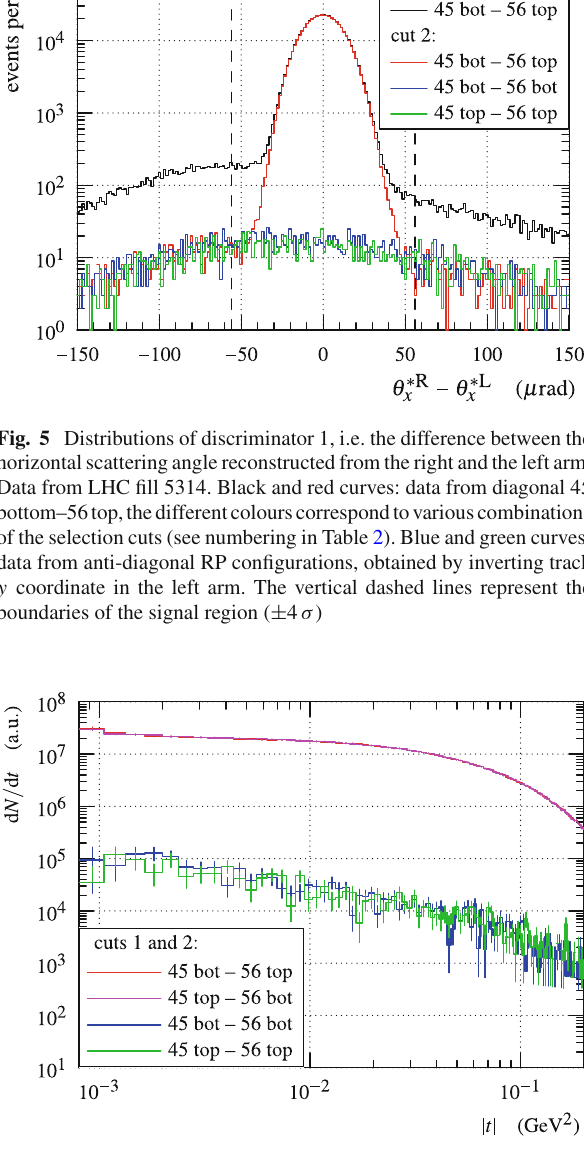
Fig. 6 Comparison of | t | -distributions from different diagonal (signal + background) and anti-diagonal (background) configurations, after all cuts and acceptance correction. Data from the LHC fill